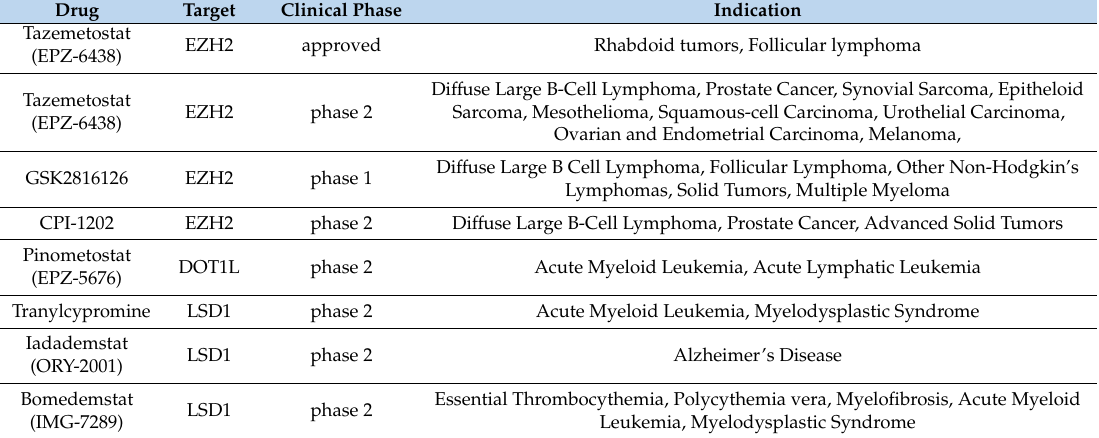
Table 1. Clinical development stage of histone methyltransferase enzymatic